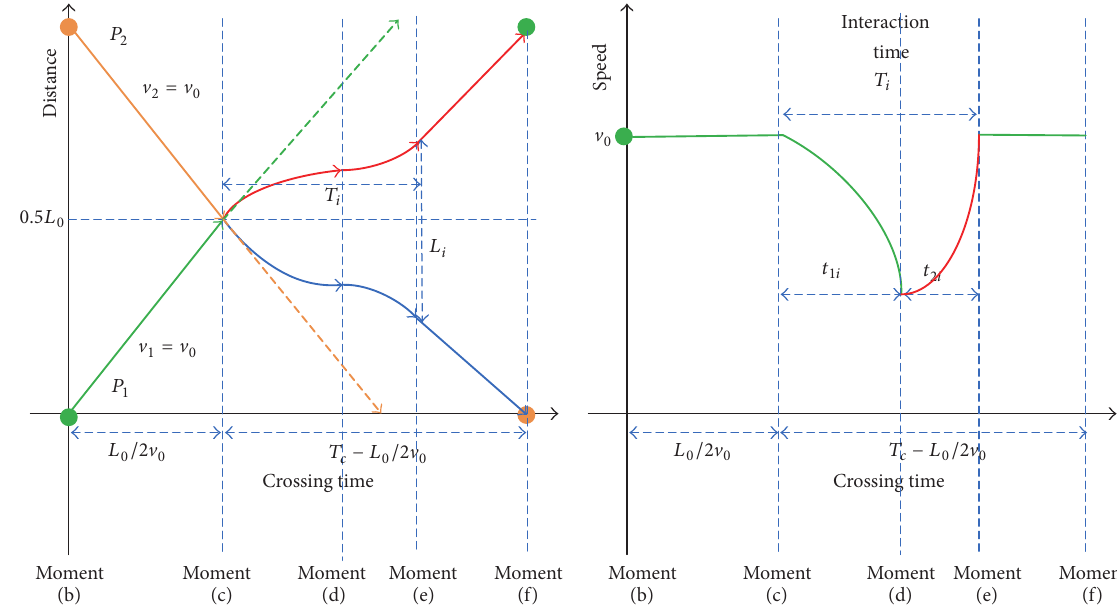
Figure 11: Time-space diagram for bidirectional pedestrian